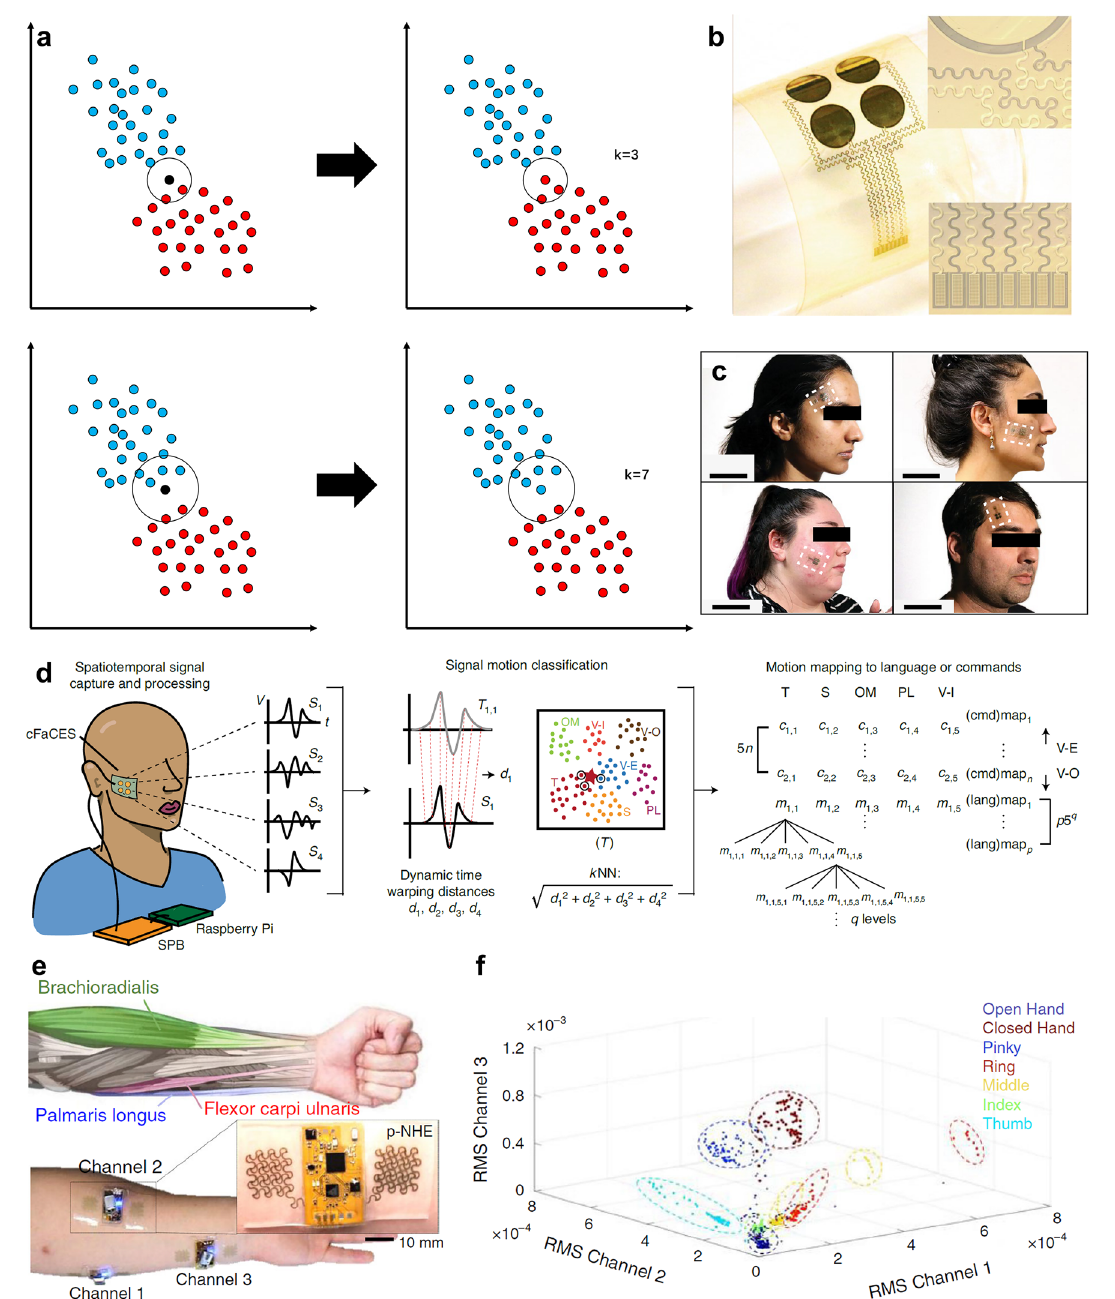
Fig. 21 Signals detected by the soft system and processed by kNN. a Schematic diagram of kNN ( k = 3 and k = 7). b Conformable sensor laminated onto a curved glass cylinder. Insets: the edge of the AlN sensing element and serpentine electrodes (top right); and the set of eight serpentine electrodes from four sensing ele- ments connecting to Al bonding pads (bottom right). c cFaCES (white dashed box) laminated onto various testers at different positions of the face. d Schematic of the EMG RTD system. A cFaCES with four sensing elements is laminated onto the face and connected to a signal processing board (SPB) for differential signal amplification and analog-to-digital conversion. Then, the digital signal from the SPB is fed to the Raspberry Pi, which automatically detects facial motions and classifies it. The classification is based on a kNN-DTW algorithm, where the k = 3. The dataset contains seven motions: twitch (T), smile (S), open mouth (OM), pursed lips (PL), mouthing the vowel ‘I’ (V–I), mouthing the vowel ‘E’ (V–E), and mouthing the vowel ‘O’ (V–O), which can be mapped to five selector motions (T, S, OM, PL, and V–I) to select options within each command or language message menu. Reproduced with permission [316]. Copyright (2020), Springer Nature. e Schematic illustration (top) of target muscles on forearm to recognize multiple gestures and photographs (bottom) capturing three p-NHE positioned on targeted muscles, including palmaris longus, brachioradialis, and flexor carpi ulnaris. Enlarged image of the system with a circuit and electrodes. f 3D plot of three-channel, EMG root-mean-square (RMS) signals for clear differentiation of seven different gestures. Reproduced with permission [30]. Copyright (2020), Springer